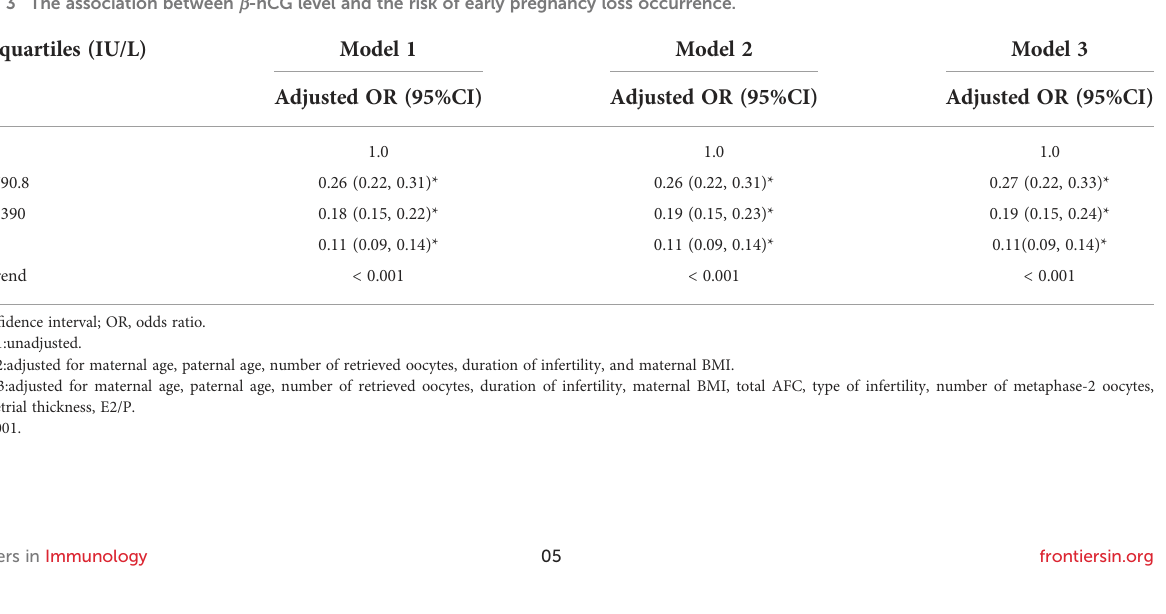
We performed ROC curve analyses to explore the predictive value of serum b -hCG levels and other risk factors for EPL (Figure 4). The AUC for the b -hCG level was 0.7477, which was signi fi cantly higher than maternal age, paternal age, total AFC, and endometrial thickness (Figure 4A and Table 4). The best b - hCG threshold value for predicting EPL based on Youden ’ s index algorithm in the ROC curve was 542.45 IU/L, with a speci fi city of 71.13%, a sensitivity of 67.71%, positive predictive value (PPV) of 28.80%, and negative predictive value (NPV) of 92.74%. Furthermore, two prediction models incorporating other risk factors were established. Model 1 incorporated other risk factors except for b -hCG, including maternal age, paternal age, AFC, and endometrial thickness; the model ’ s AUC was